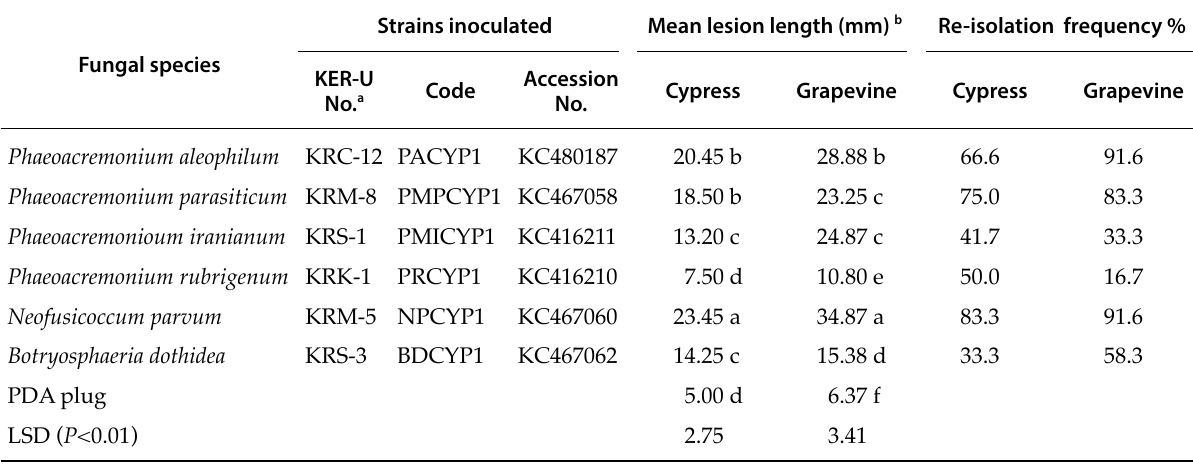
Table 2. Mean lesion length and re-isolation frequencies of fungal species inoculated into cypress stems (after 3 months) and green shoots of grapevine (after 20 days) in pathogenicity